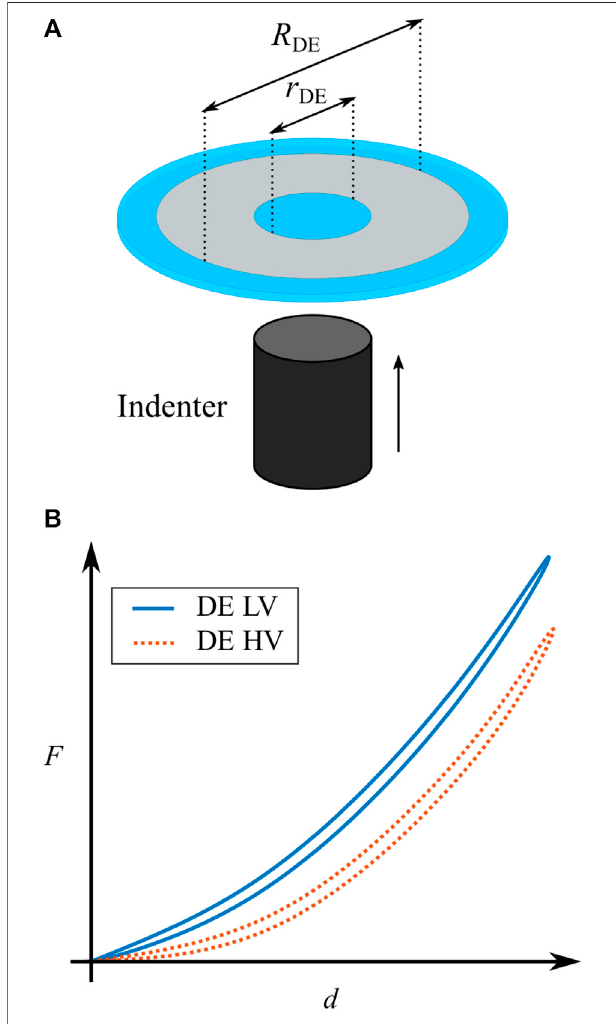
FIGURE 2 | (A) Schematic depiction of a COP-DEA, active electrode- coveredmaterial(depictedingray)andpassiveelastomermaterial(depictedin blue). (B) Qualitative sketch of the two characterizing curves of a COP-DEA. Thebluecontinuouslinerepresentsthelowvoltagecurveandthedotted red line represents the high voltage